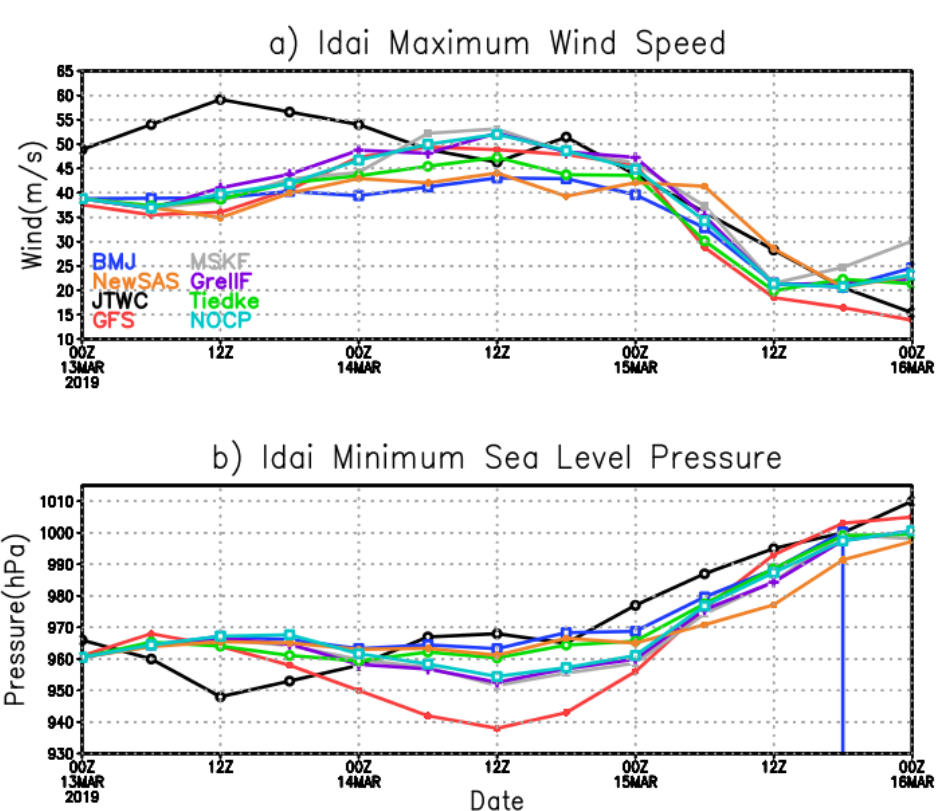
Figure 8. Six hourly ( a ) maximum wind speed and ( b ) minimum SLP as simulated by WRF and GFS and from the JTWC best track